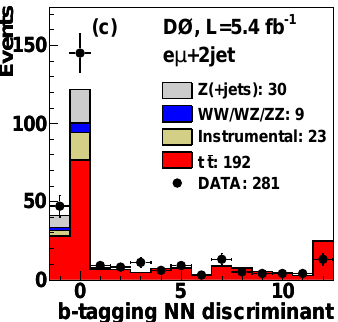
= 7 . 36 + 0 . 90 of 12% resulting in σ (stat + syst + lumi) pb. tt 0 . 79 − The result is dominated by the systematic uncertainty with the largest uncertainty from luminosity of 0.57 pb. Figure 3 shows the output of the b -tagging discriminant for events with at least two jets in e µ channel in data and simulation.